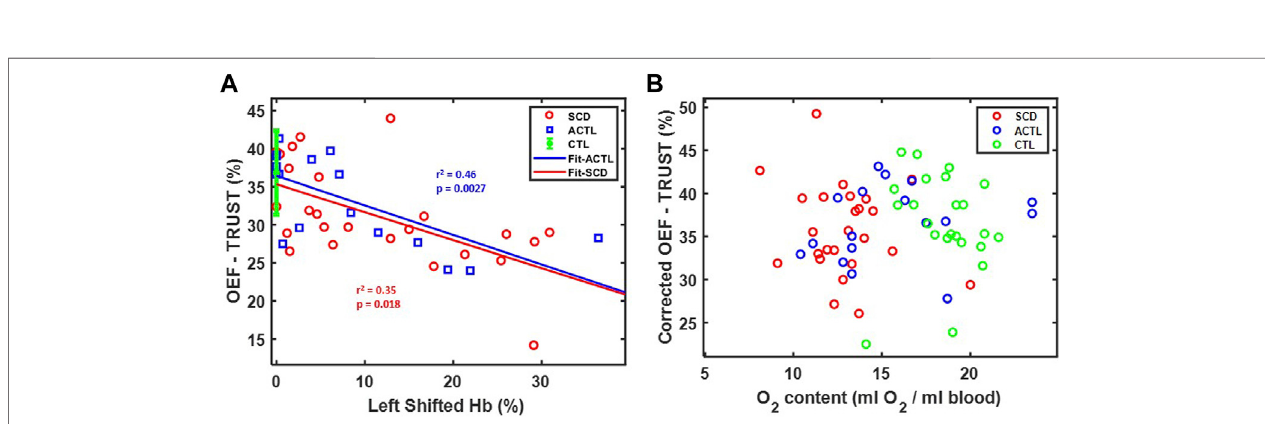
FIGURE 5 | (A) Relationship between OEF-TRUST with left shifted hemoglobin. Linear correlations are shown in blue line ( r 2 = 0.46, p = 0.0027) for ACTL and red line ( r 2 = 0.35, p = 0.0018) for SCD. The control group is shown as 36.8 ± 5.5 (mean ± std) in green. (B) Relationship between corrected OEF-TRUST with O 2 content.